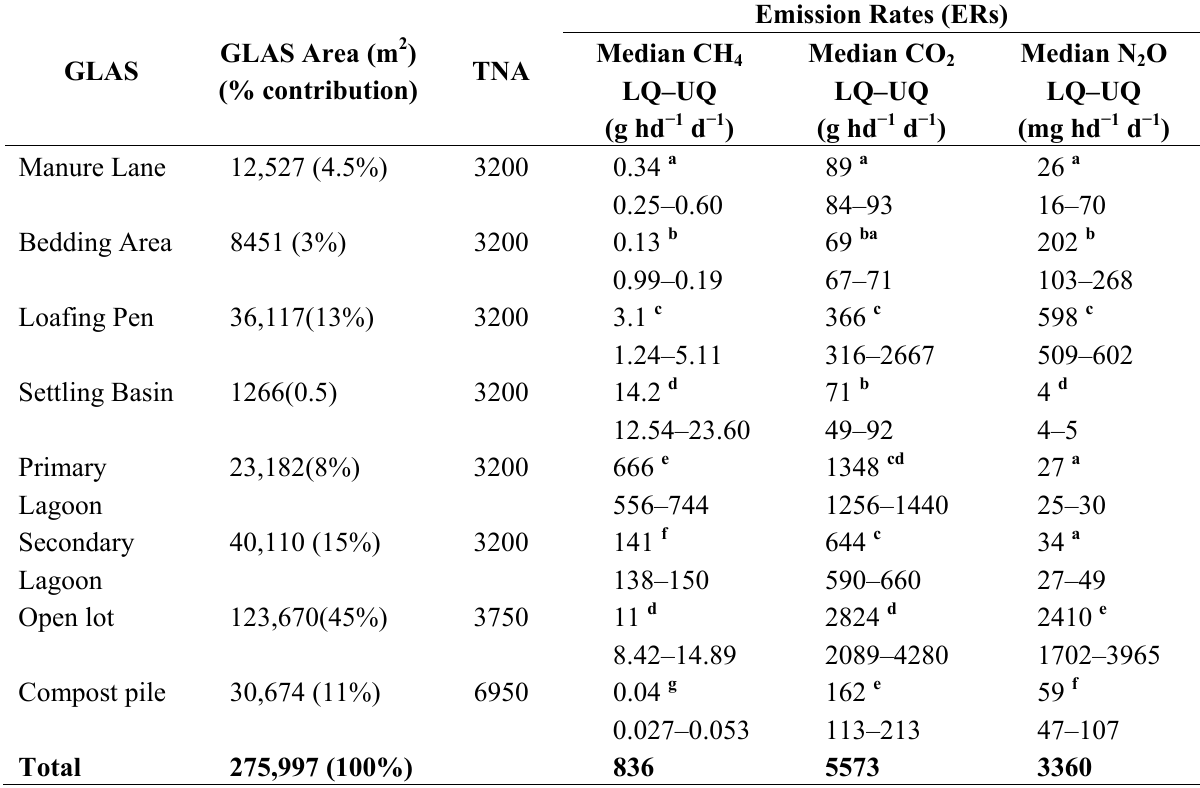
Table 3. Estimated GHG ERs (median and quartiles) from various GLAS of the free-stall dairy during the